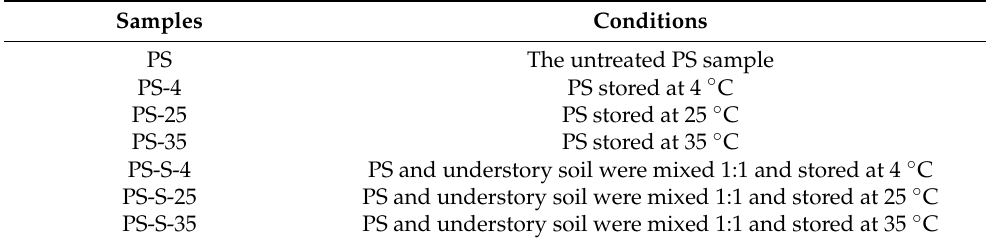
Table 1. The conditions of PS